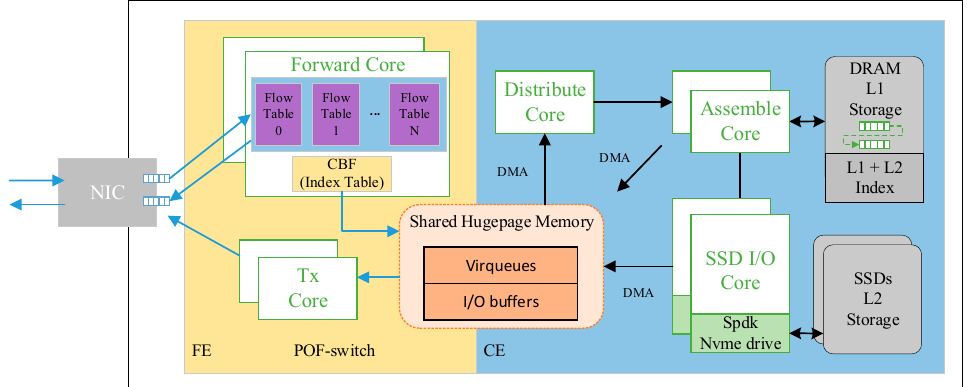
Figure 4. Implementation of the cache-supported ICN router.